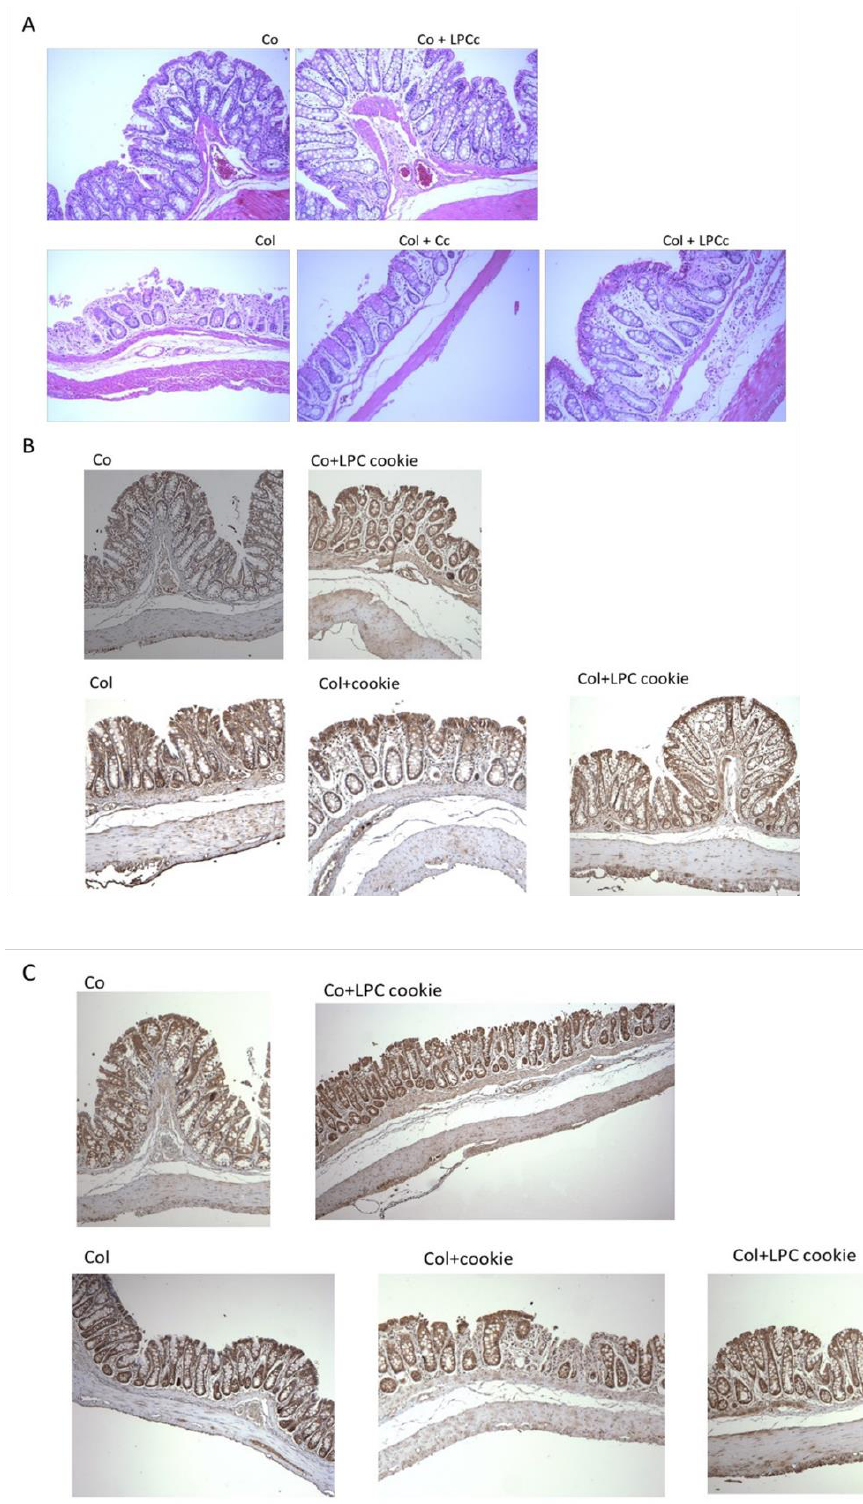
Figure 4. Effect of administration of deflamin cookies on colon tissues. ( A ) Histopathological alterations in colitis in colon tissue. ( B ) Immunohistochemical detection of COX-2. ( C ) Immunohisto- chemical detection of TNF- α. Co: control; Co + LPCc: control + LPC cookie; Col: colitis; Col + Cc: colitis + control cookie; Col + LPCc: colitis + LPC cookie. All images are at a magnification of 100×. Table 3. Expression of the positive pixels as the mean ± SD obtained for each colon tissue. Co: con- trol; Co + LPCc: control + LPC cookie; Col: colitis; Col + Cc: colitis + control cookie; Col + LPCc: colitis